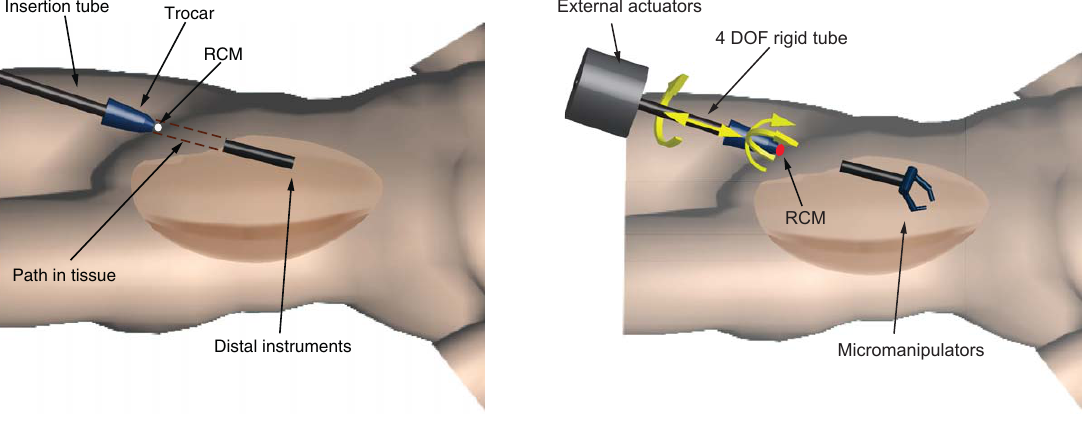
Fig. 1. Subcutaneous surgical tunnelling procedure. Fig. 2. Conceptual representation of the surgical